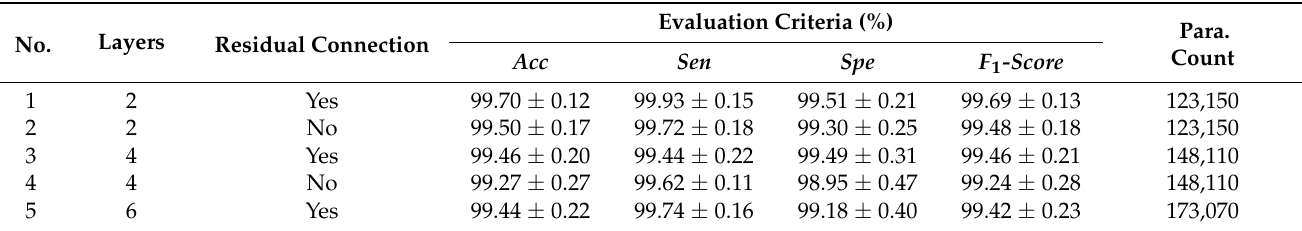
Table 6. The performance of pseudo-siamese convolutional neural networks based on the structure in Figure